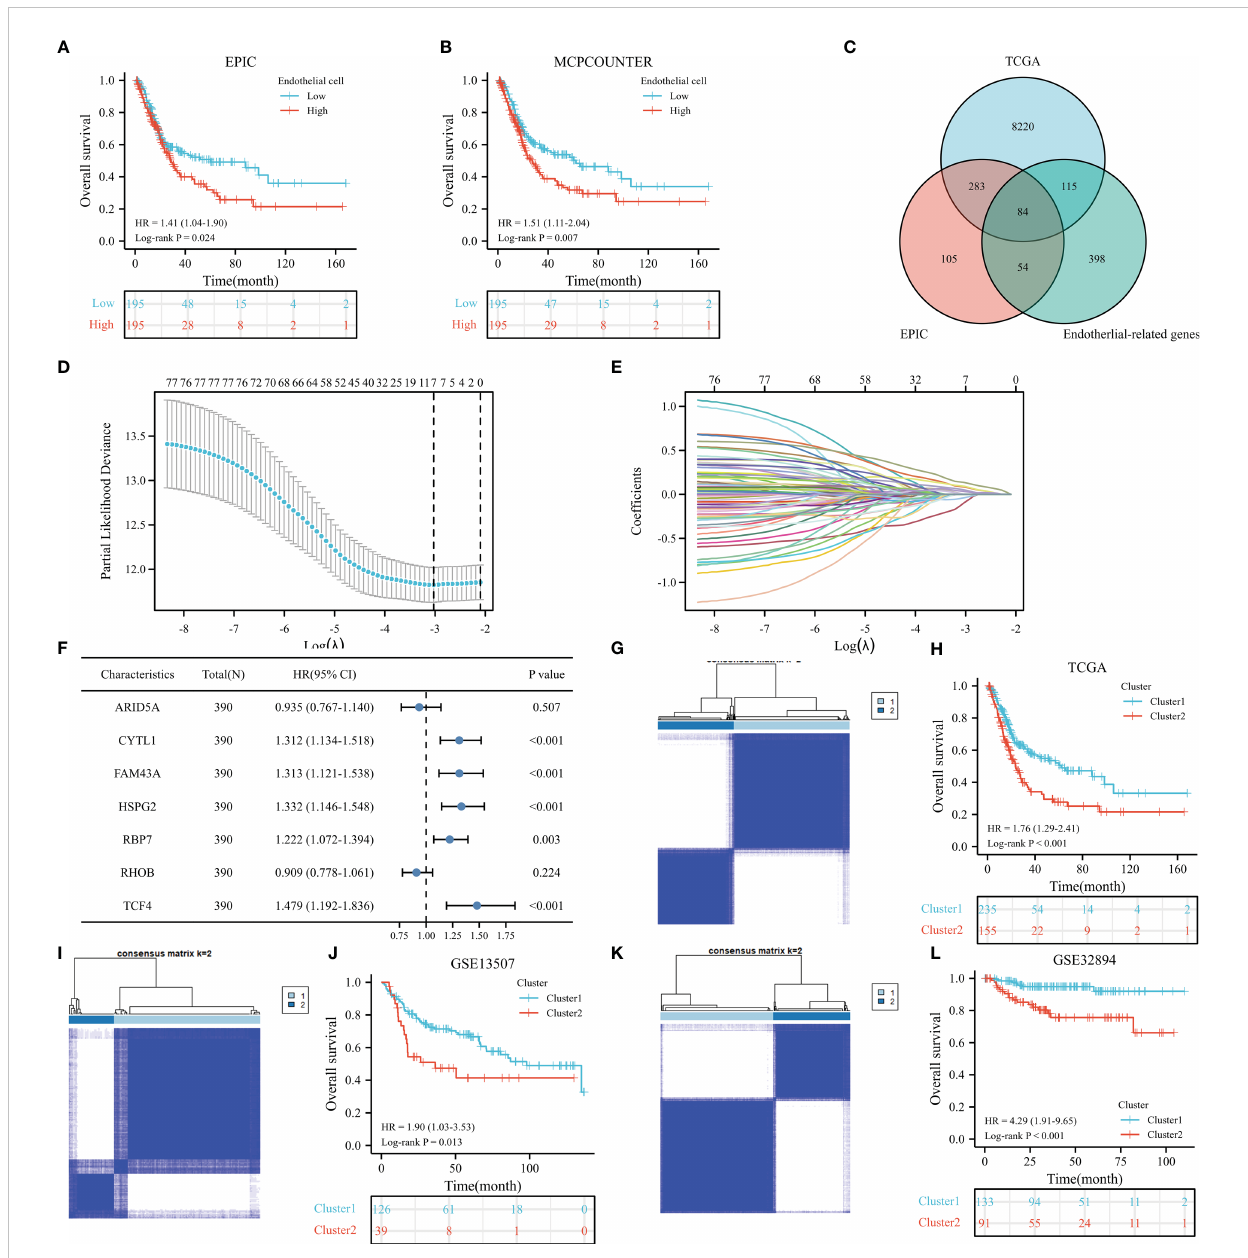
FIGURE 2 The prognostic value of endothelial cells based on the results of EPIC (A) and MCPCOUNTER algorithms (B) , the co-expressed genes (C) , the cross- validation to determine the optimal penalty parameter lambda (D) , Lasso regression of the seven endothelial cell-related genes (E) , the prognostic value of these seven genes in overall survival (OS) according to the results of univariable Cox regression analysis in TCGA dataset (F) , cluster plot showing two distinct groups in the TCGA database (G) , the Kaplan − Meier analysis results of OS in TCGA dataset (H) , cluster plot showing two distinct groups in the GSE13507 database (I) , the Kaplan − Meier analysis results of OS in GSE13507 dataset (J) , cluster plot showing two distinct groups in the GSE32894 database (K) , the Kaplan − Meier analysis results of OS in GSE32894 dataset (L)